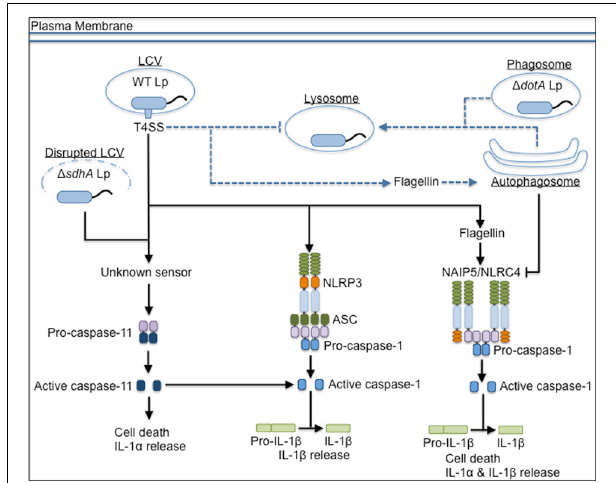
FIGURE 1 | The inflammasome-mediated response to L. pneumophila in murine macrophages. L. pneumophila that do not express a functional T4SS ( (cid:2) dotA Lp) traffic to the lysosome, but wild-type L. pneumophila (WT Lp) use the T4SS to translocate effectors into the host cytosol to establish a replicative niche, the Legionella -containing vacuole (LCV), and block fusion with lysosomes. WT Lp triggers canonical caspase-1-dependent inflammasome activation through detection of translocated flagellin by NAIP5/NLRC4. NLRP3 and ASC contribute to IL-1 β secretion in response to WT Lp. Detection of T4SS activity through an unknown sensor leads to caspase-11 activation, which contributes to inflammasome activation. Caspase-11 also responds to bacteria that aberrantly enter the cytosol ( (cid:2) sdhA Lp) due to loss of LCV membrane integrity. Translocated flagellin triggers trafficking of WT Lp to the autophagosome, and induction of autophagy negatively regulates pyroptosis if there are low levels of flagellin in the host cell cytosol. Dashed lines represent vesicular trafficking patterns. Solid lines represent pathways for activation of the host response. Arrows at the end of lines represent induction, while flat bars at the end of lines represent